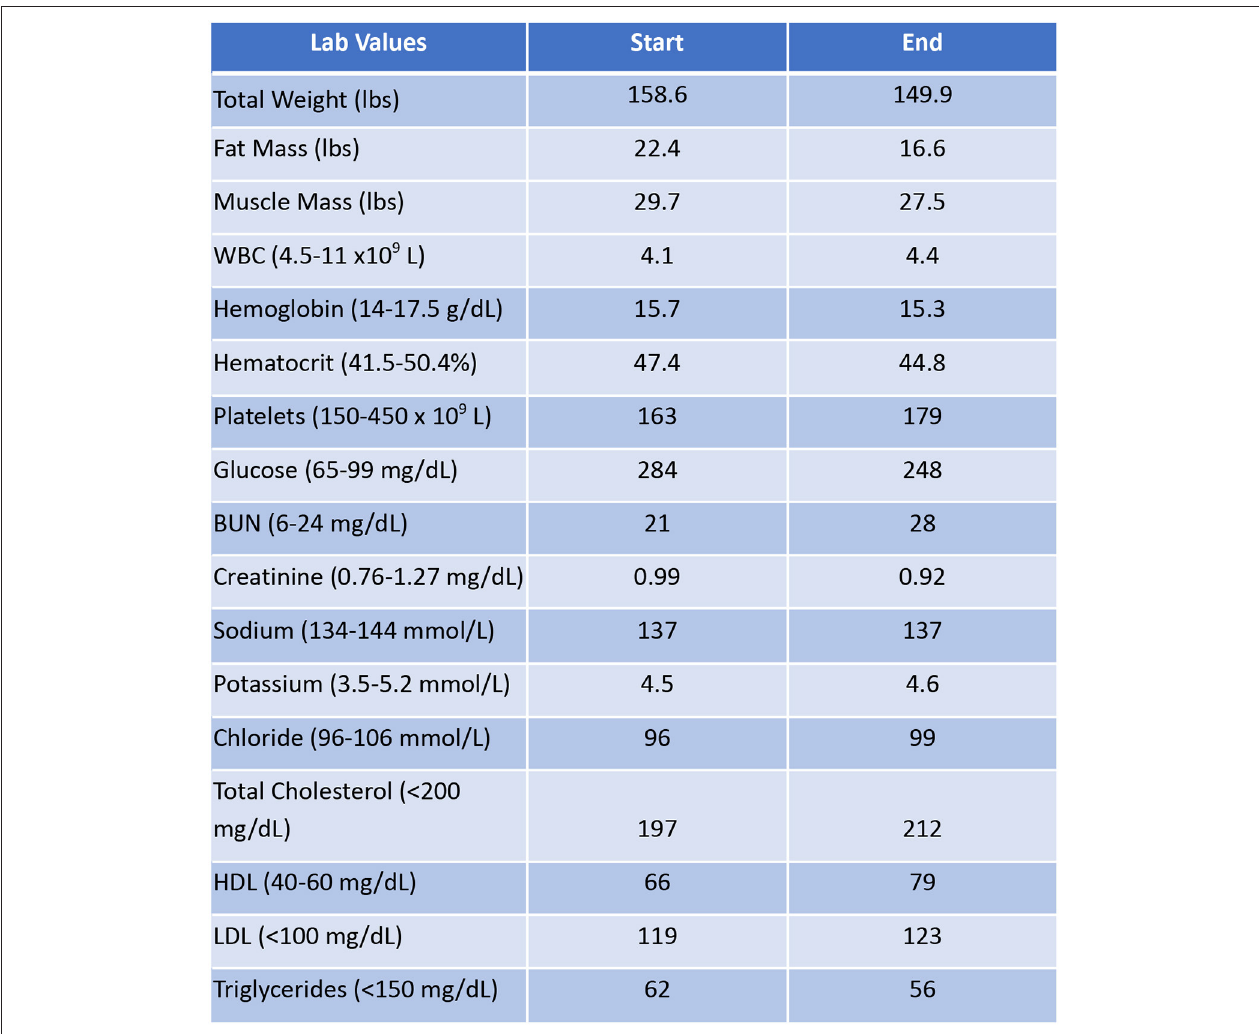
FIGURE 9 | Lab values of Patient #3 at the start and the end of the program.